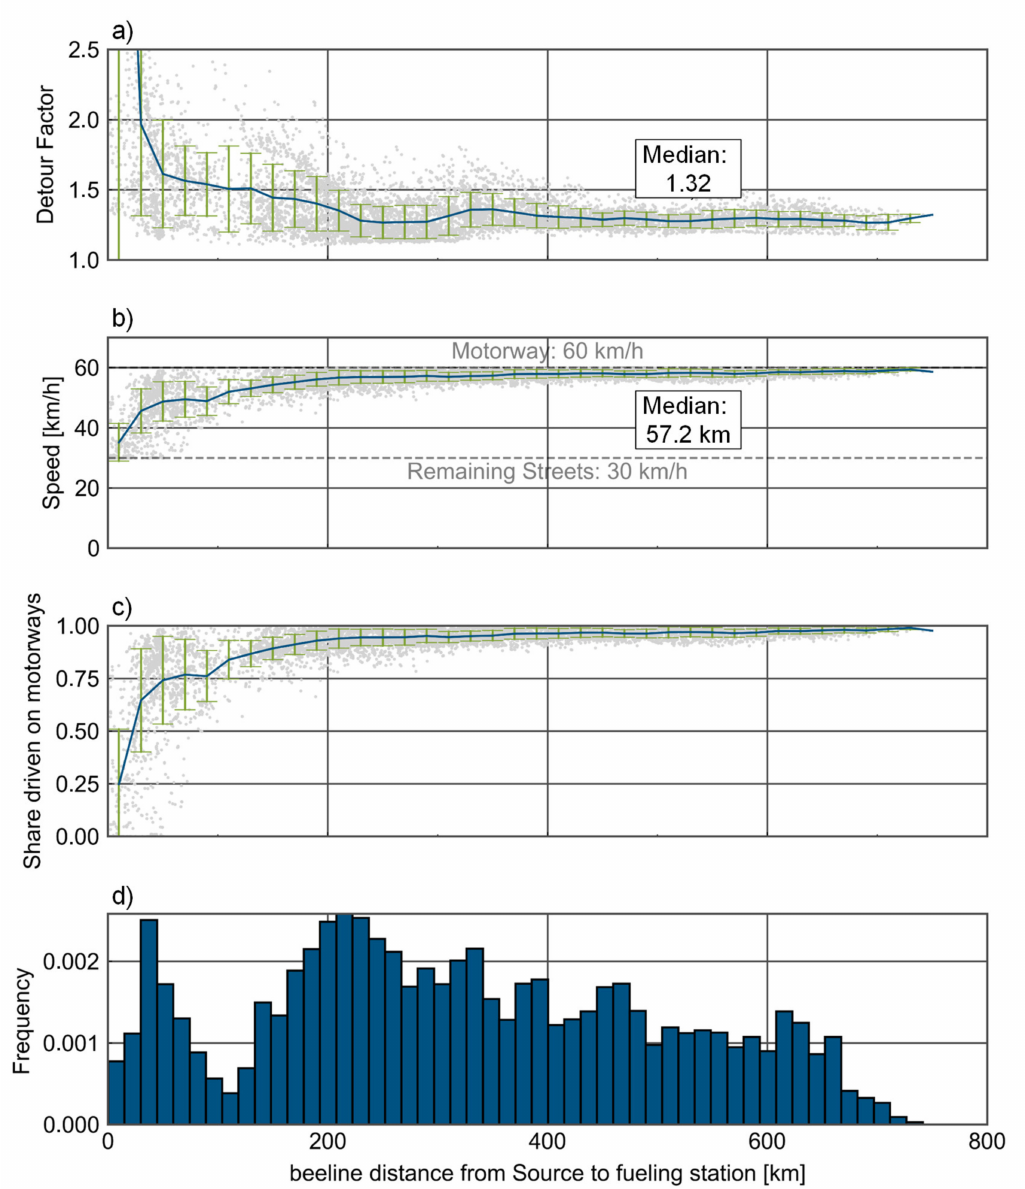
Figure 4. Detailed results of each connection from source to sink for the ( a ) detour factor, ( b ) driven speed, ( c ) share driven on highways and ( d ) frequency of the beeline distance as a function of the distance between the production sites and fueling